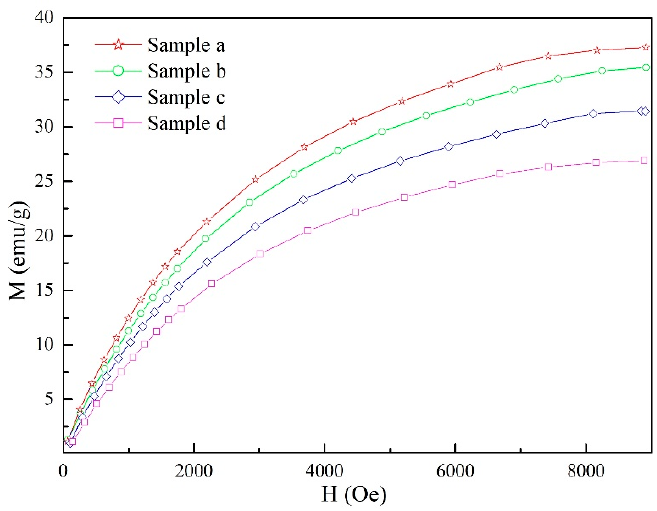
Figure 9. The magnetization curves of study samples.